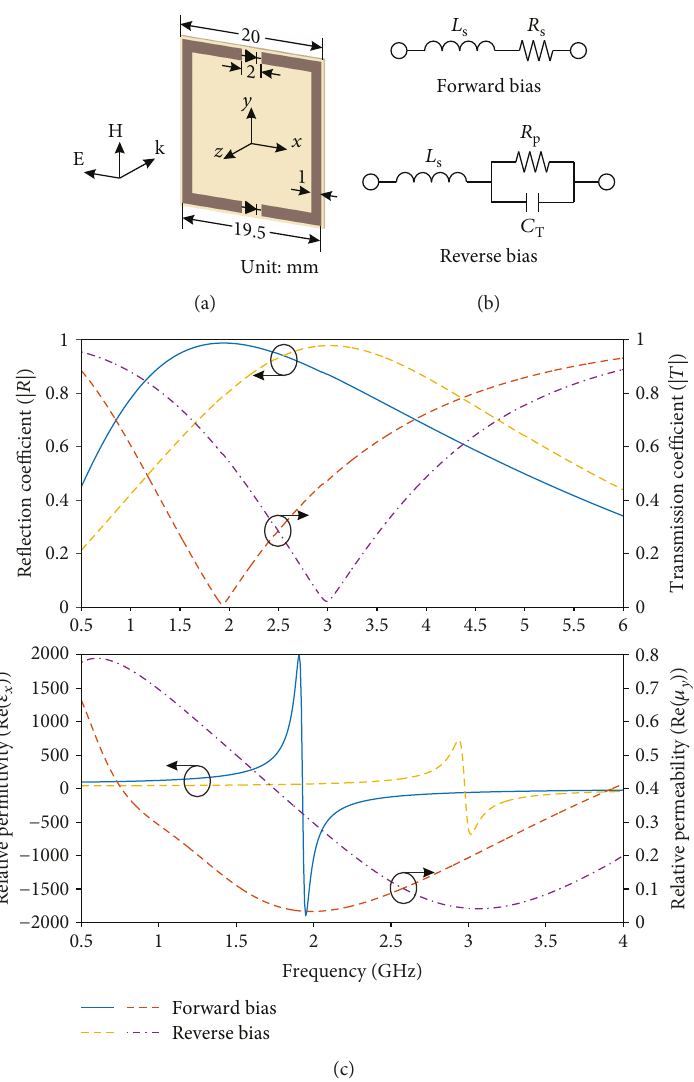
Figure 1: (a) Unit cell of the metasurface formed by square split rings loaded with two PIN diodes. (b) Equivalent circuits of the PIN diode in the forward and reverse bias states ( L s = 1 8nH , R s = 1 Ω , R p = 5 k Ω , and C T = 0 3pF ). (c) Calculated transmission and re fl ection coe ffi cients and retrieved relative permittivity and permeability of the metasurface formed by double-split square rings loaded with PIN diodes in forward and reverse bias